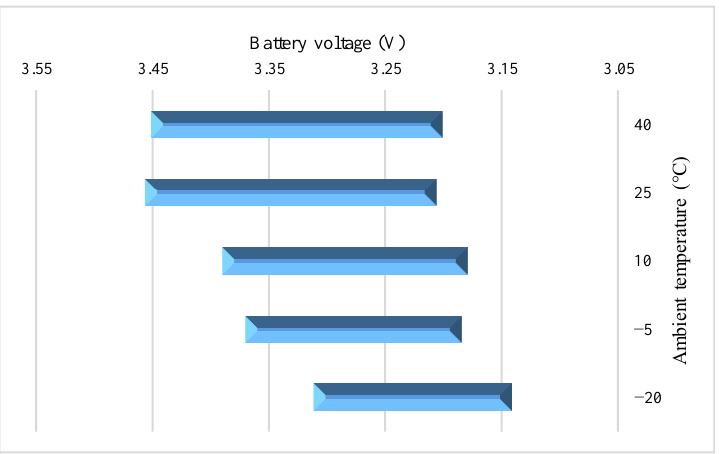
Figure 14. The voltage variation interval diagram of the voltage plateau period during 0.75C discharge.